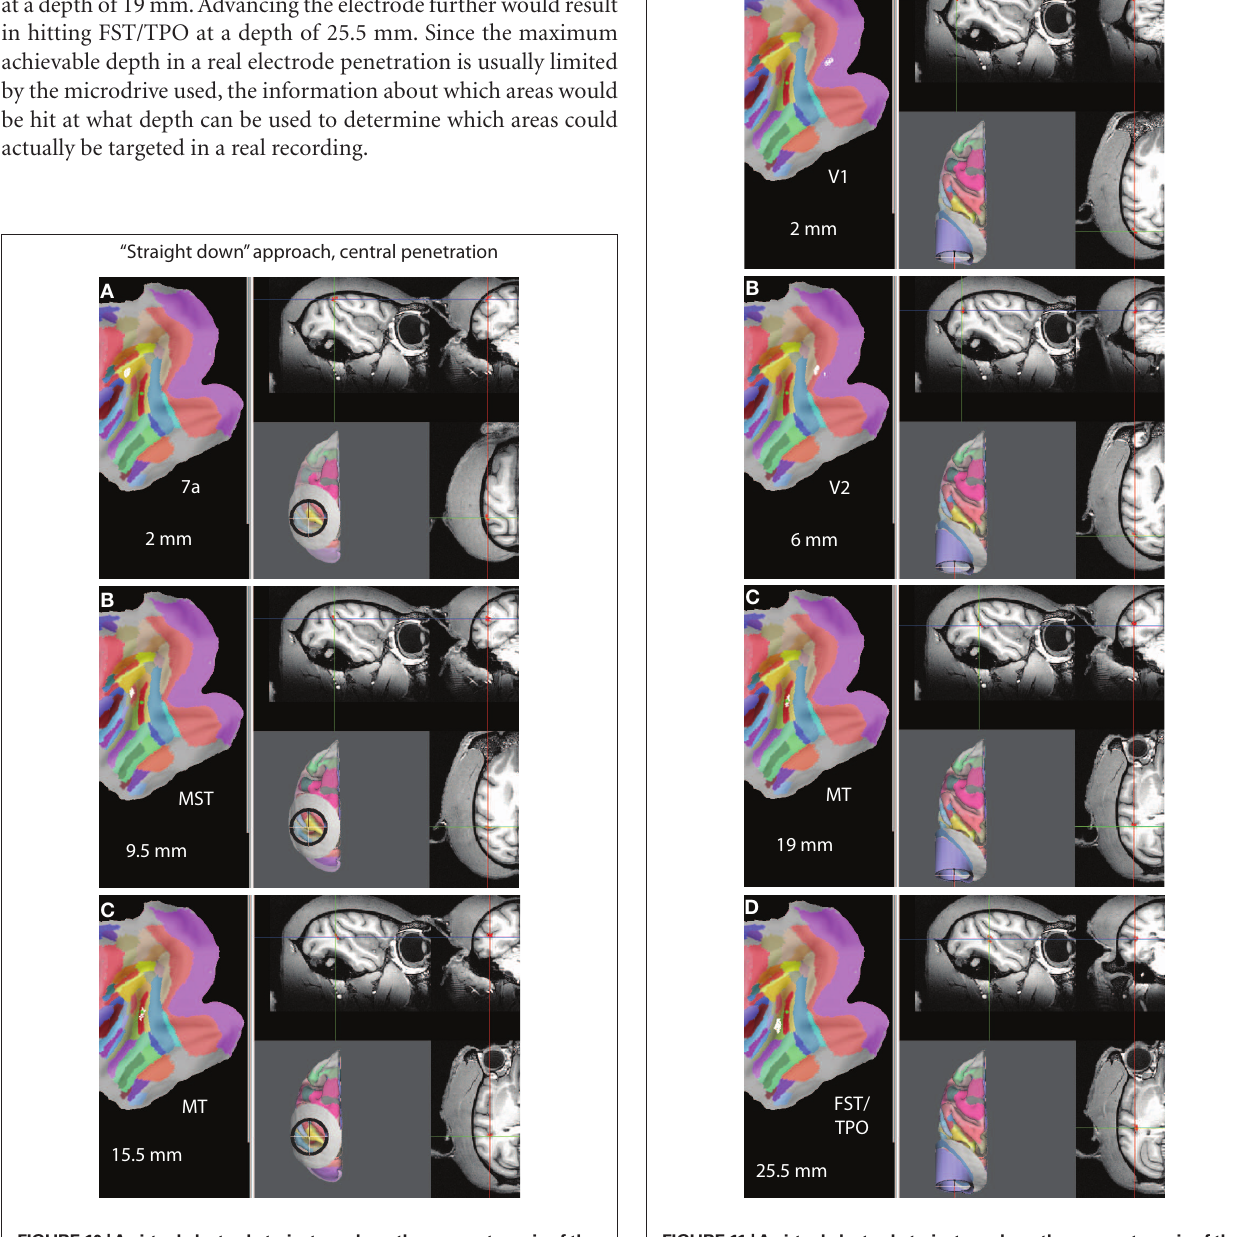
Figure 11 | A virtual electrode trajectory along the symmetry axis of the “from behind” approach (elevation of − 70 ° and tilt of zero). (A) Hitting V1 at a depth of 2 mm. (B) Hitting V2 at a depth of 6 mm. (C) Hitting MT at a depth of 19 mm. (D) Hitting FST/TPO at a depth of 25.5 mm.